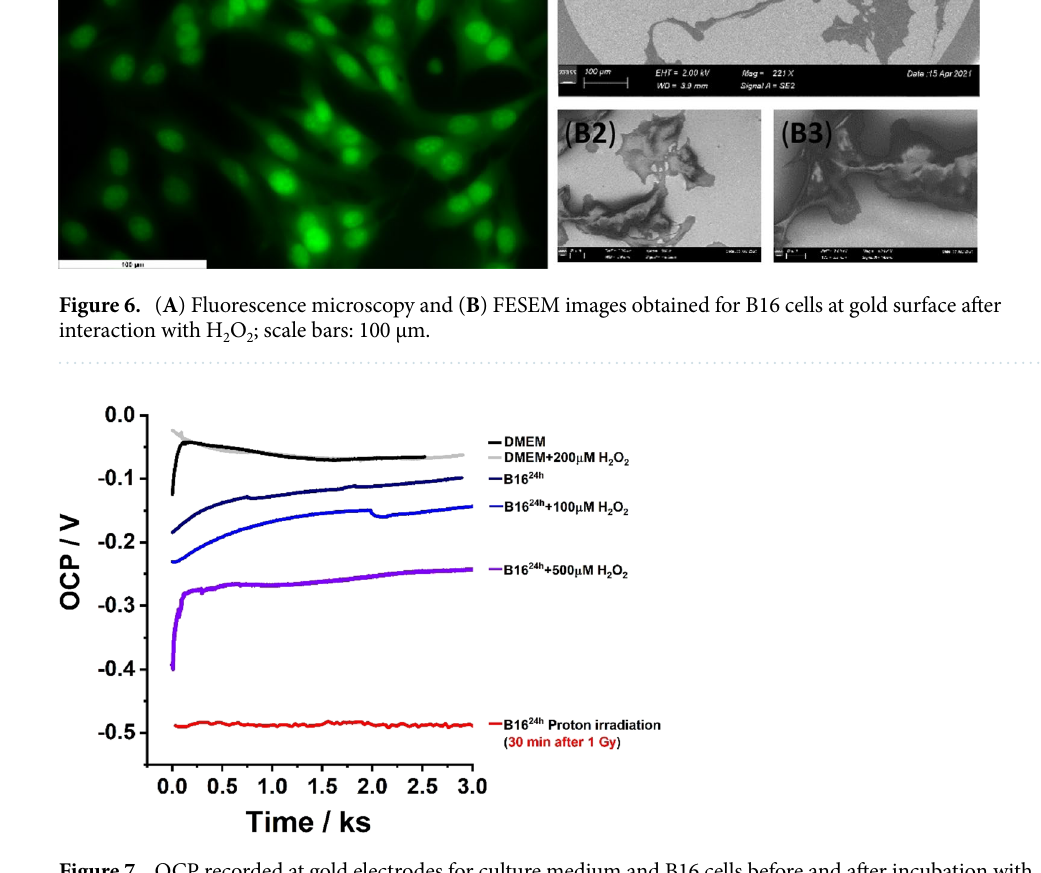
Figure 7. OCP recorded at gold electrodes for culture medium and B16 cells before and after incubation with H 2 O 2 and proton irradiation (1 Gy at 1